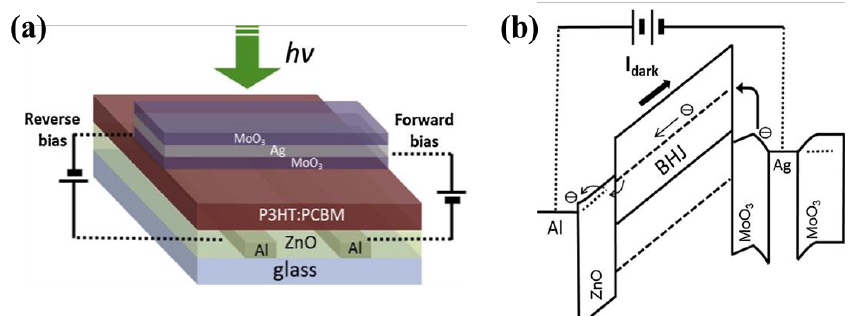
Figure 18. ( a ) The device structure of the top anode OPD with top illumination; ( b ) Band diagram of the OPD with reverse bias under dark conditions. The arrows show the carrier injection mechanism at each electrode and the direction of the dark current. (Reproduced with permission from [148]. ELSEVIER Publishing, 2015).